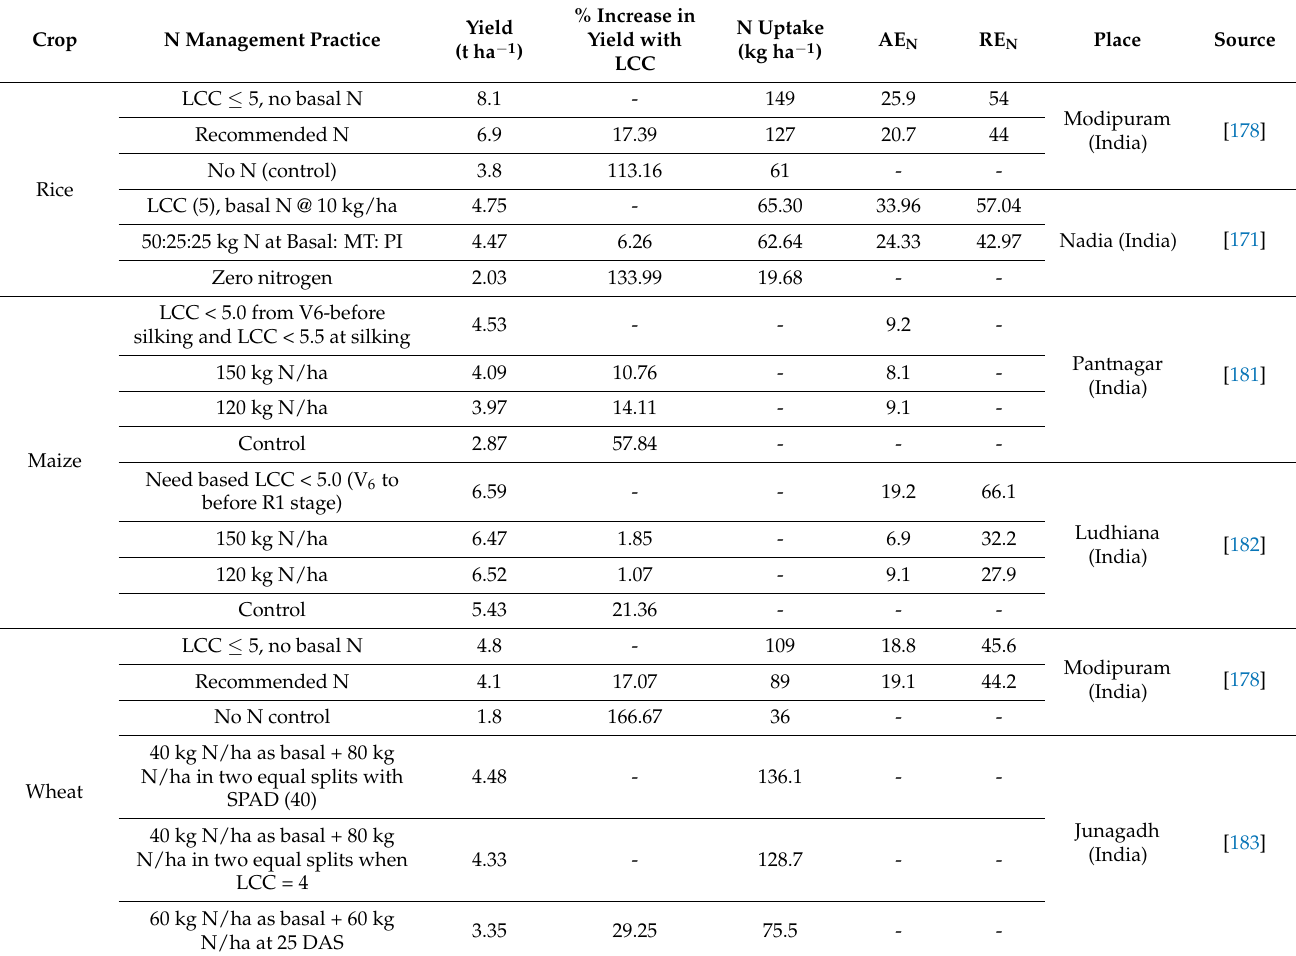
Table 4. Effect of leaf color chart (LCC)-based N management on grain yield, nitrogen uptake, and NUE.